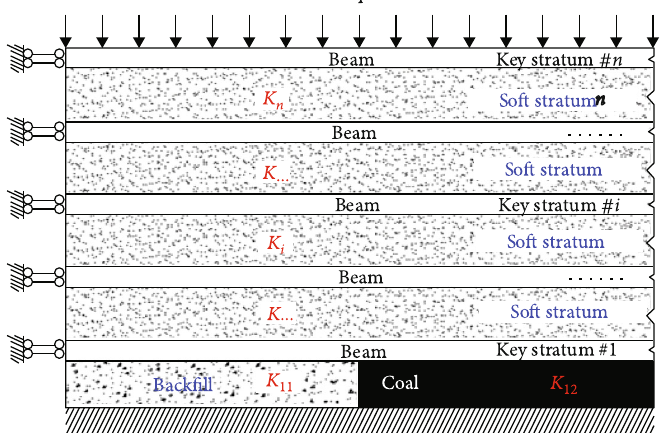
Figure 3: Multilayer Winkler foundation beam model of overburden in fi lled mining.